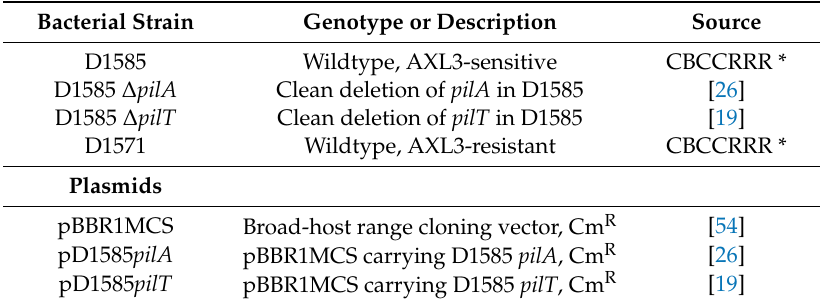
Table 4. Strains and plasmids used in this